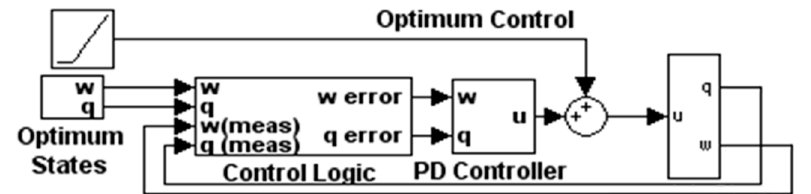
Figure 9. 2DOF Implementation in SIMULINK.